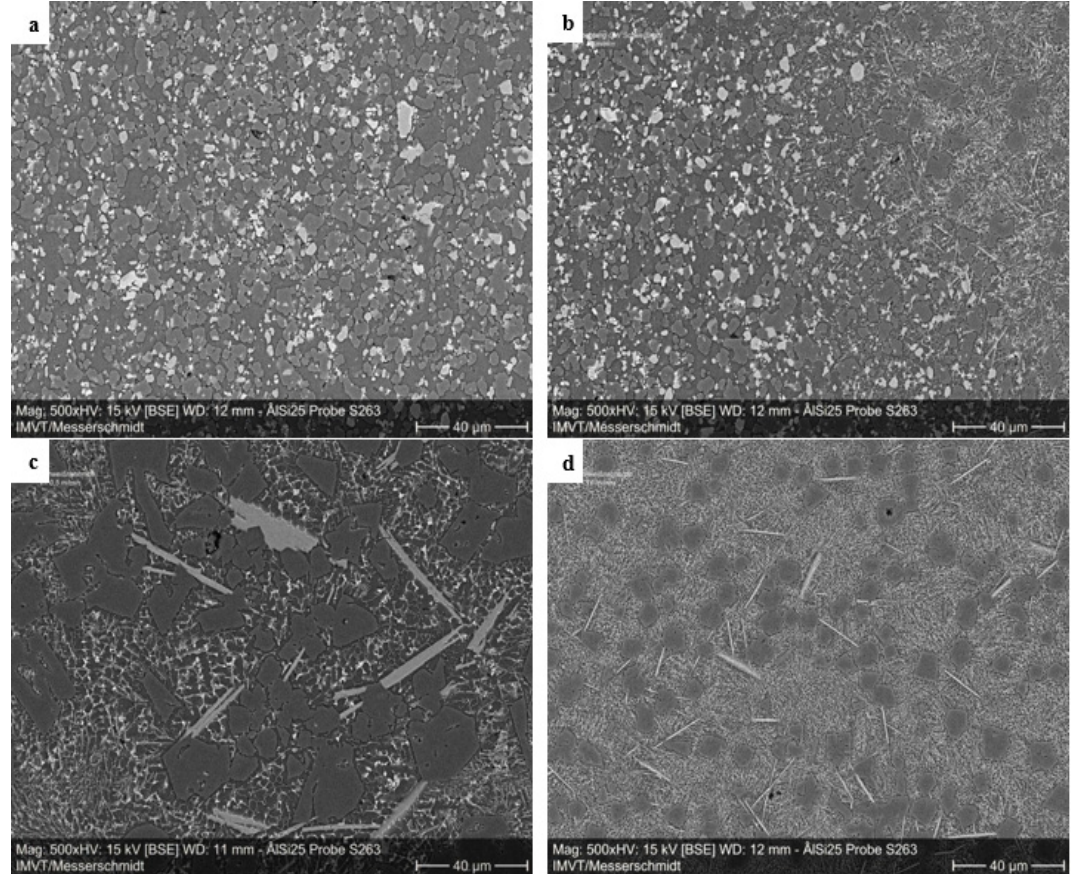
Figure 10. S263: ( a ) Base material; ( b ) Transition of weld seam to base material; ( c ) Center of the weld seam for v = 0.5 m/min; ( d ) Center of the weld seam for v = 10 m/min.